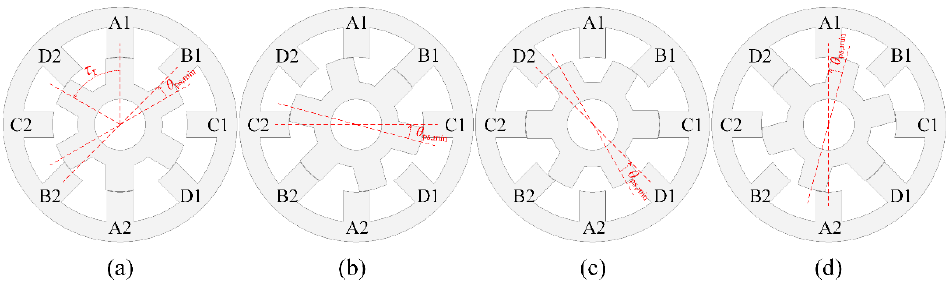
Figure 3. Aligned positions of the four-phase 8/6 SRM. ( a ) Phase A. ( b ) Phase B. ( c ) Phase C. ( d ) Phase D.